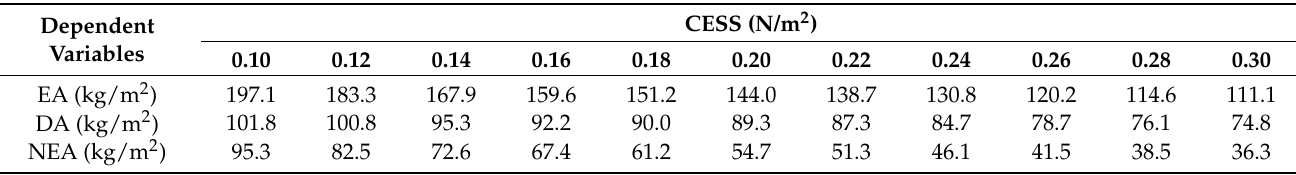
Table 1. Erosion amount (EA), deposition amount (DA), and net erosion amount (NEA) per unit area for different CESSs after 100 years.